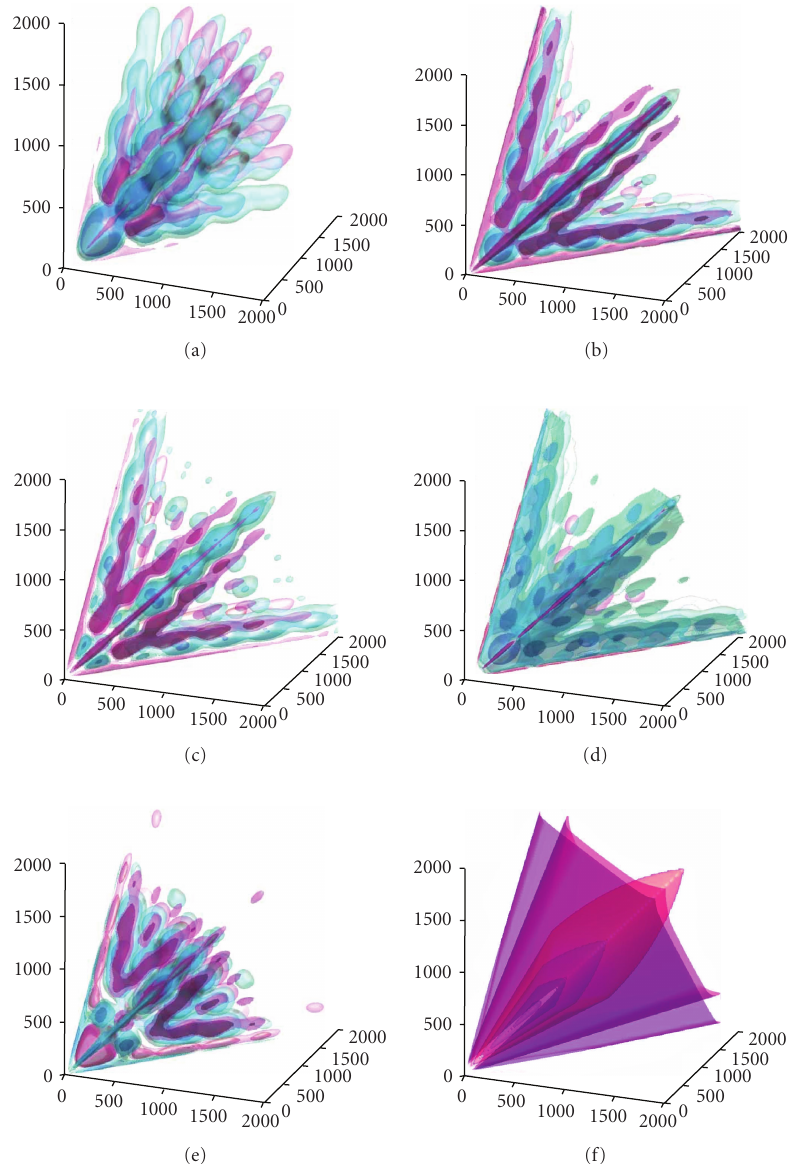
Figure 8: The reduced CMB bispectra for several non-Gaussian models, including ((a), (b) and (c)) equilateral, local, and flattened models and ((d), (e), and (f)) warm, feature, cosmic string models (see main text). All five primordial models are normalised relative to the constant solution (48) and are taken from the study by Fergusson and Shellard in [9]. The analytic cosmic string bispectrum (64) is multiplied by ( (cid:9) 1 (cid:9) 2 (cid:9) 3 ) 4 / 3 and is taken from the study by Regan and Shellard in